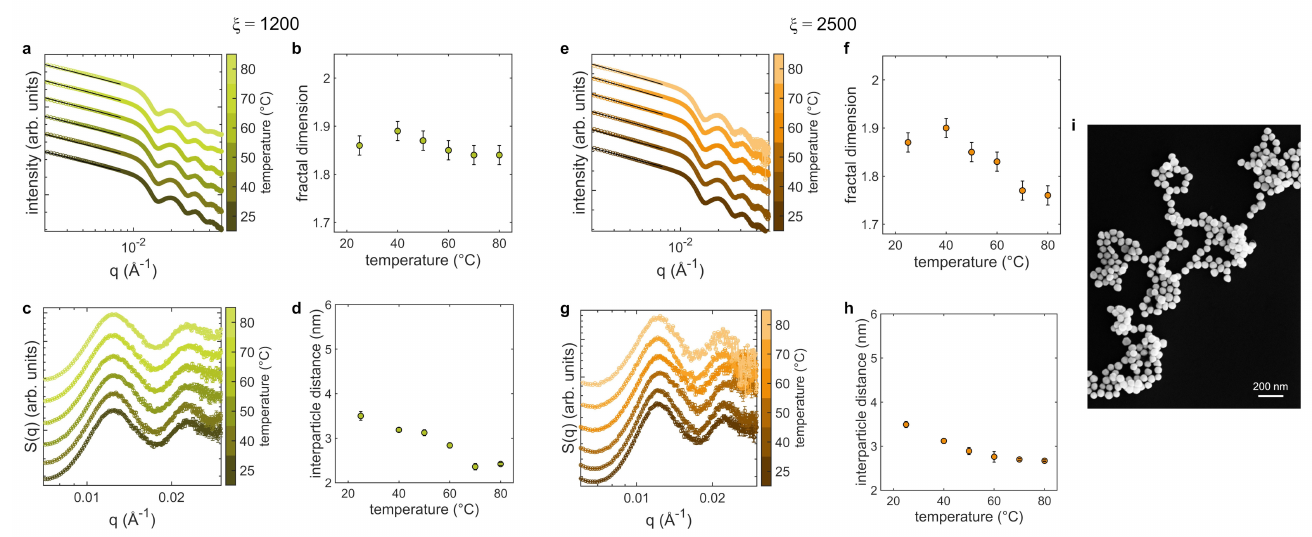
Figure 6. SAXS analysis of the AuNPs clusters morphology as a function of temperature (from 25 °C to 80 °C), performed at pH 6.5 for two different lysozyme-AuNPs number ratios, ξ = 1200 and ξ = 2500. ( a , e ) SAXS curves (circles) and power-law decay fitting curves (black lines); ( b , f ) fractal dimension as a function of temperature; ( c , g ) structure factors; ( d , h ) interparticle distance as a function of temperature; ( i ) representative SEM image of the assemblies obtained for ξ = 2500 and deposited at 80 °C. SAXS curves and structure factors are vertically shifted for